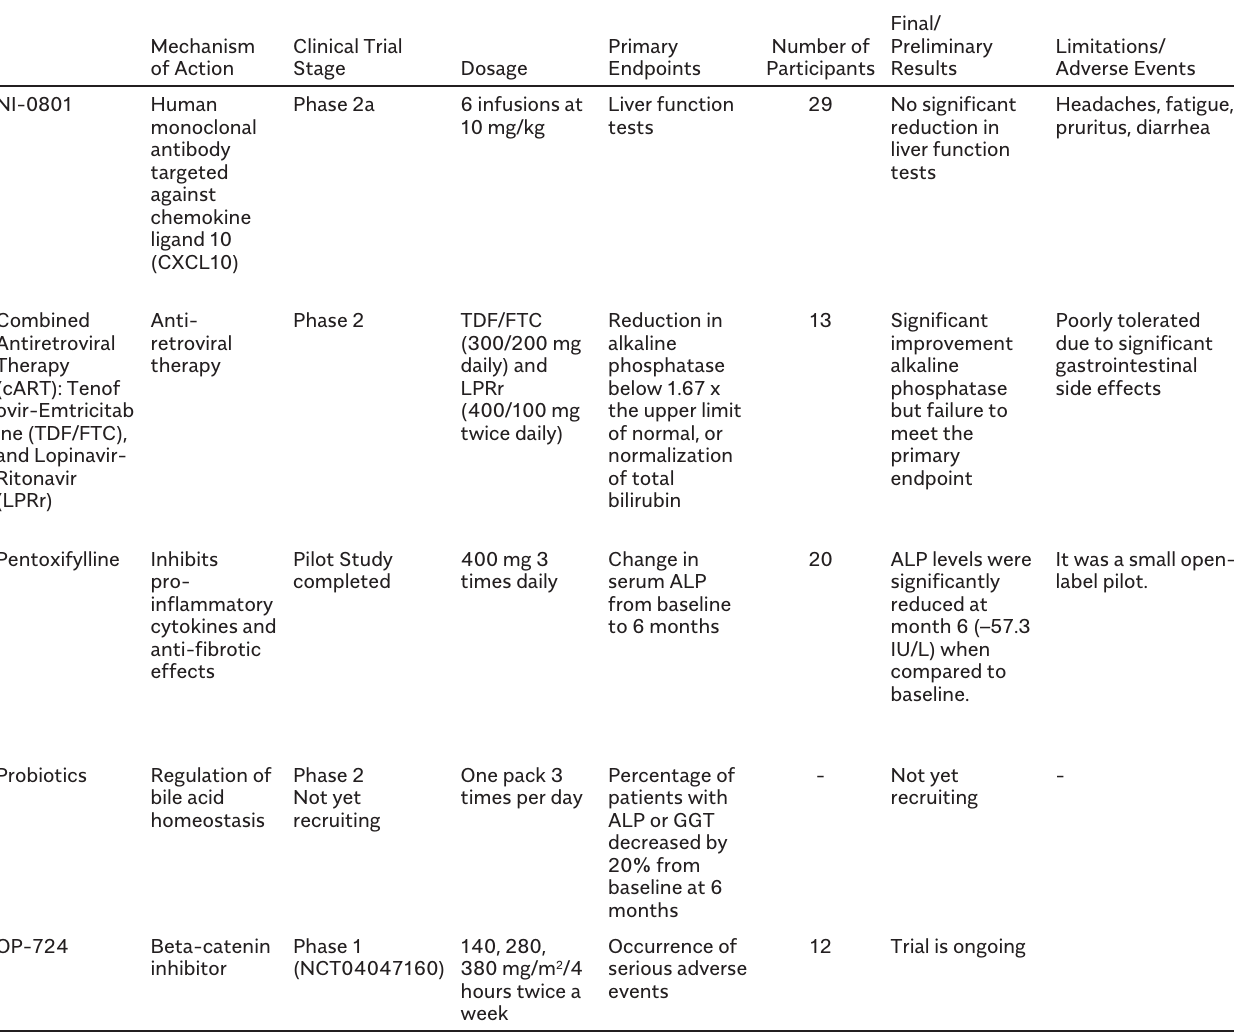
Table 2. Investigational Therapeutics for the Treatment of Primary Biliary Cholangitis